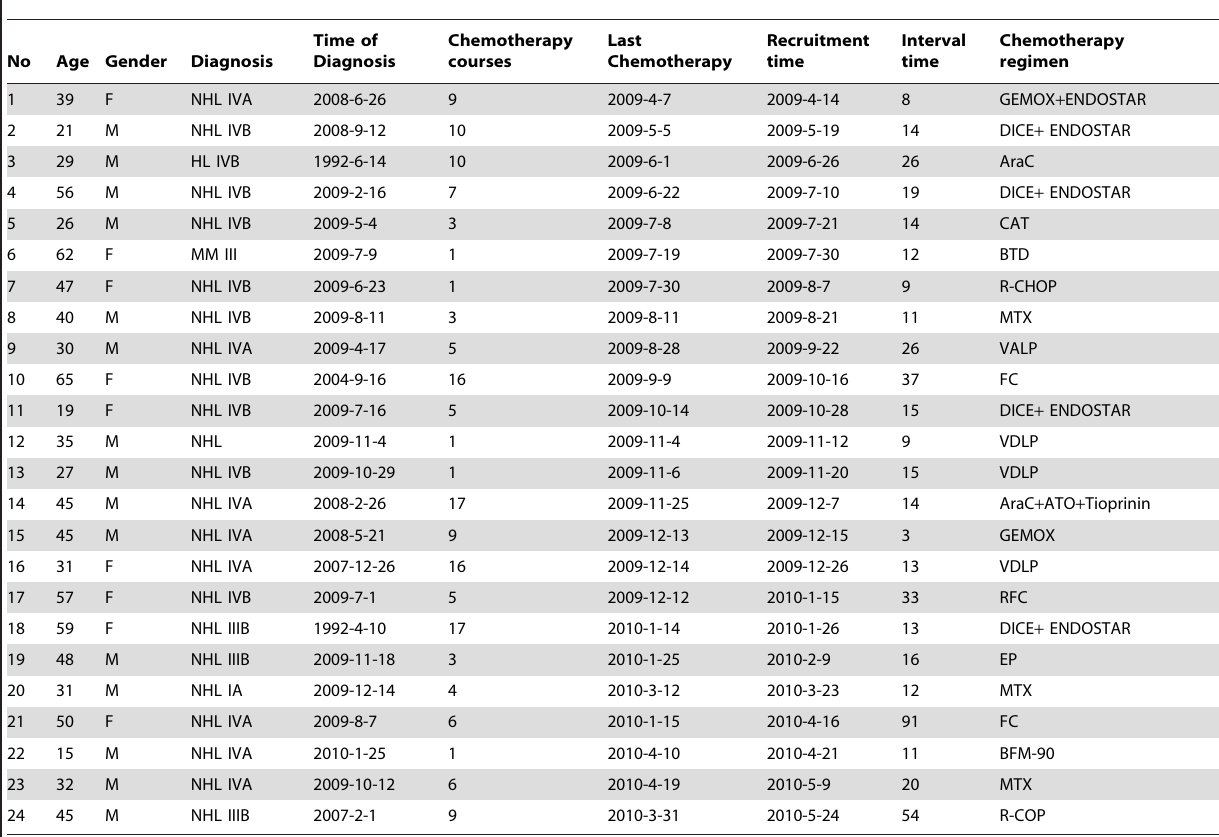
Table 1. Patient